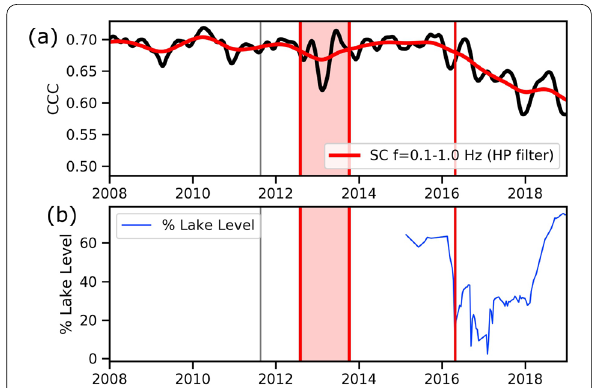
Fig. 8 a Cross Correlation Coefficient (CCC) derived from seismic noise interferometry and ( b ) % of lake level derived from InSAR. The black and red lines in ( a ) correspond to the daily mean values across different combinations of components (EN, EZ and ZN) smoothed using a Hodrick–Prescott filter with different values, 500,000 and 100,000,000, respectively. See Fig. 4 for the description of the vertical lines corresponding to key time periods